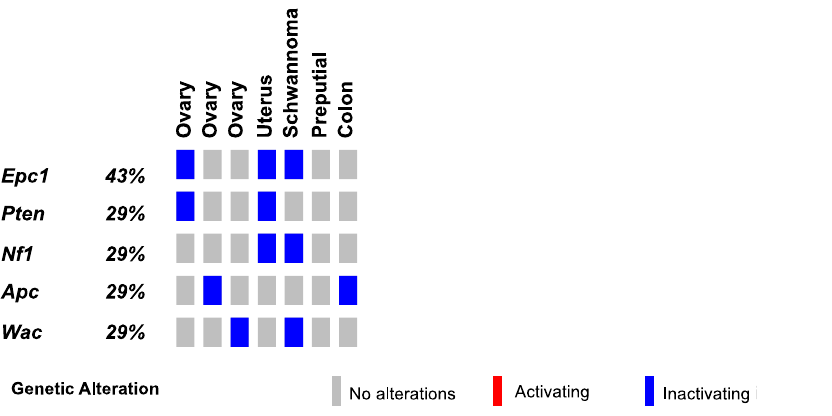
Figure 5. SB-driven gynecologic and other cancer histologies by cumulative tumor suppression. Recurrent inactivating SB insertions in Onc2.3-induced ovary, uterus, Schwannoma, preputial gland, and colon